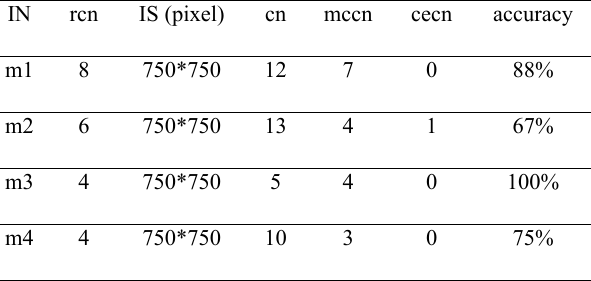
Table 2 Quantitative analysis experiment results of